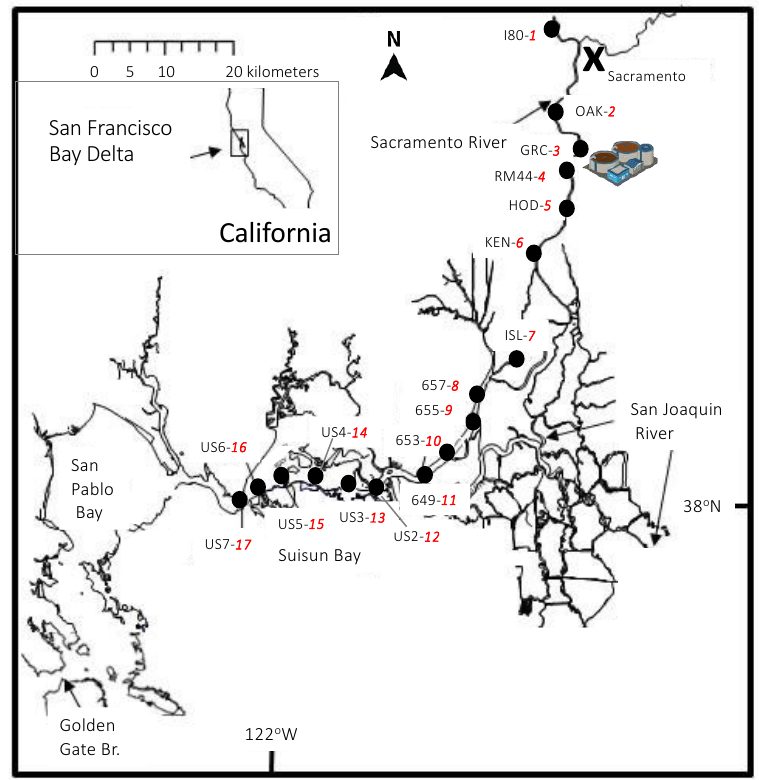
Figure 1. Map of the San Francisco Bay Delta showing the sites sampled over the study years. Each station is identified by a number (in red) and by a regional name. The WWTP that underwent an upgrade and reduction in nitrogen effluent in 2021 is shown with the WWTP icon near Station 3 (GRC). The WWTP icon is from the University of Maryland Integration and Application Network image library.